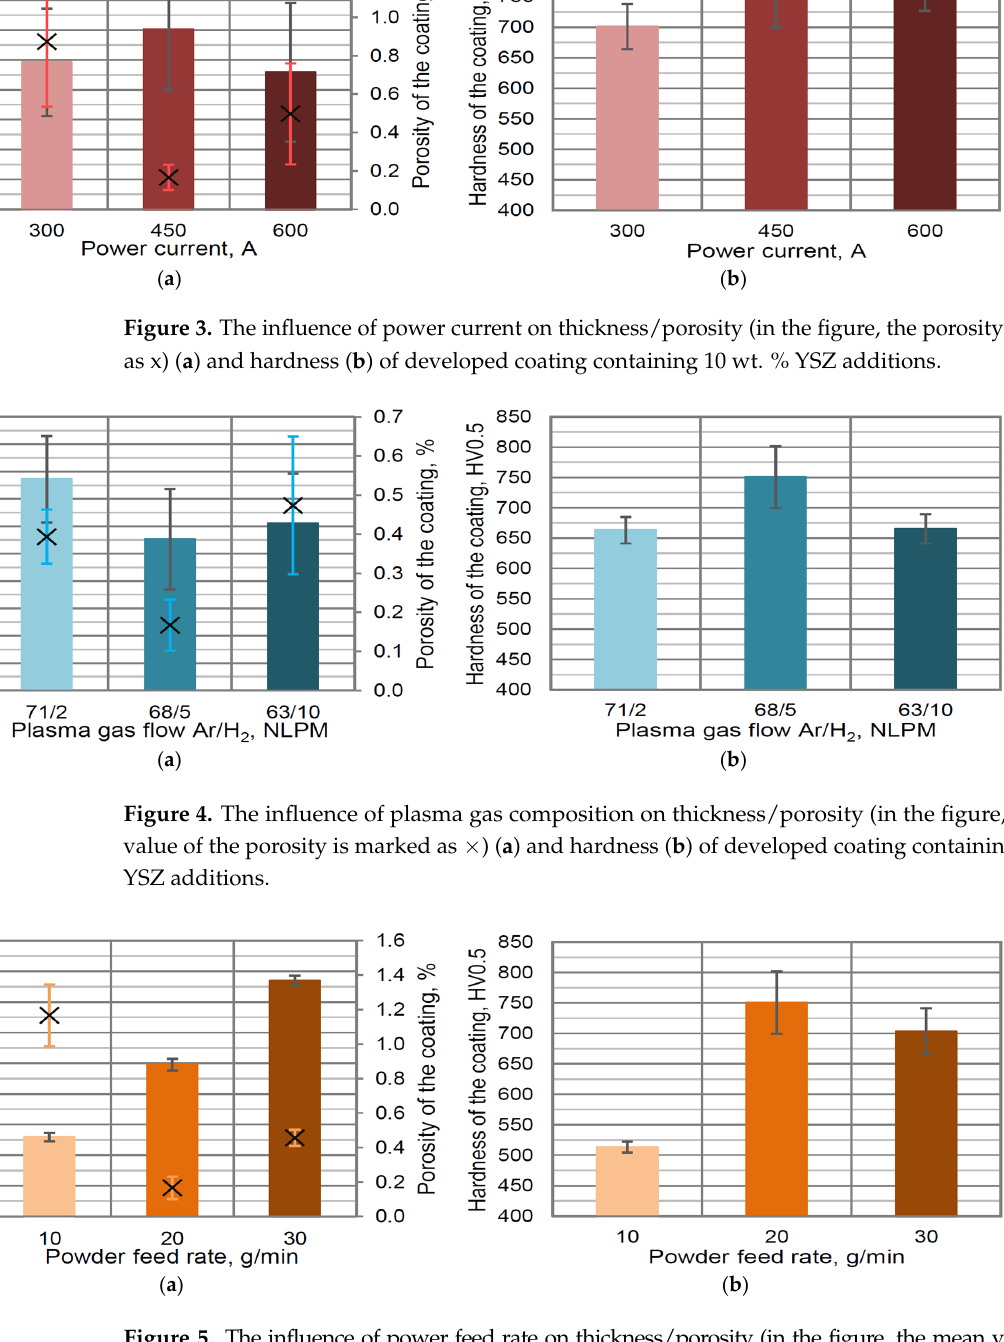
Figure 3. The influence of power current on thickness/porosity (in the figure, the porosity is marked as x) ( a ) and hardness ( b ) of developed coating containing 10 wt. % YSZ additions. The influence of the plasma gas composition (especially the hydrogen flow rate) was